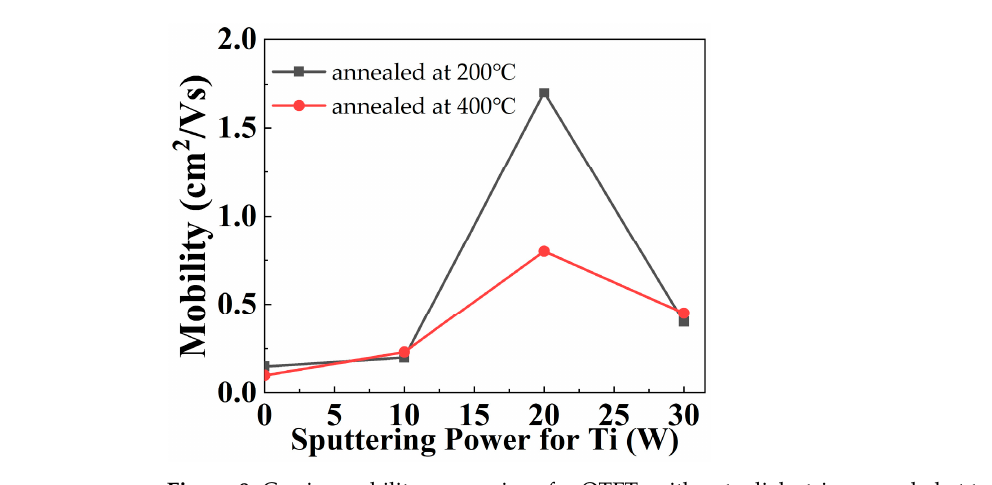
Figure 8. Carrier-mobility comparison for OTFTs with gate dielectrics annealed at two tempera- tures.